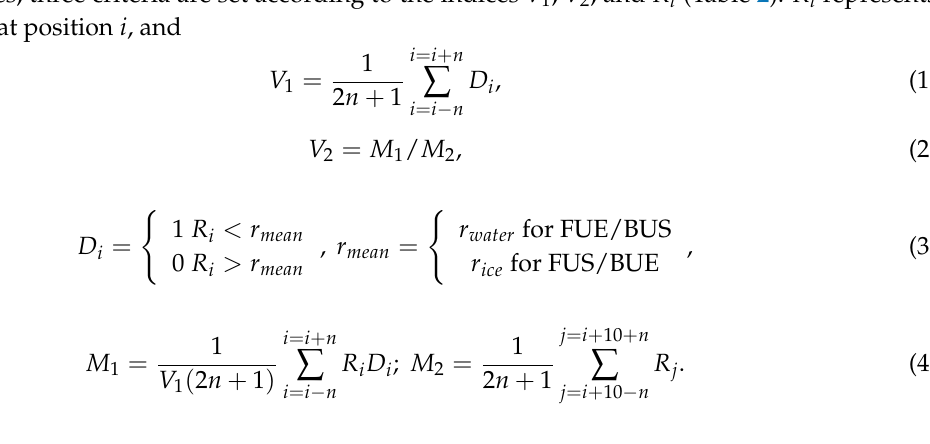
Table 2. Criteria of phenology determination based on reflectance temporal